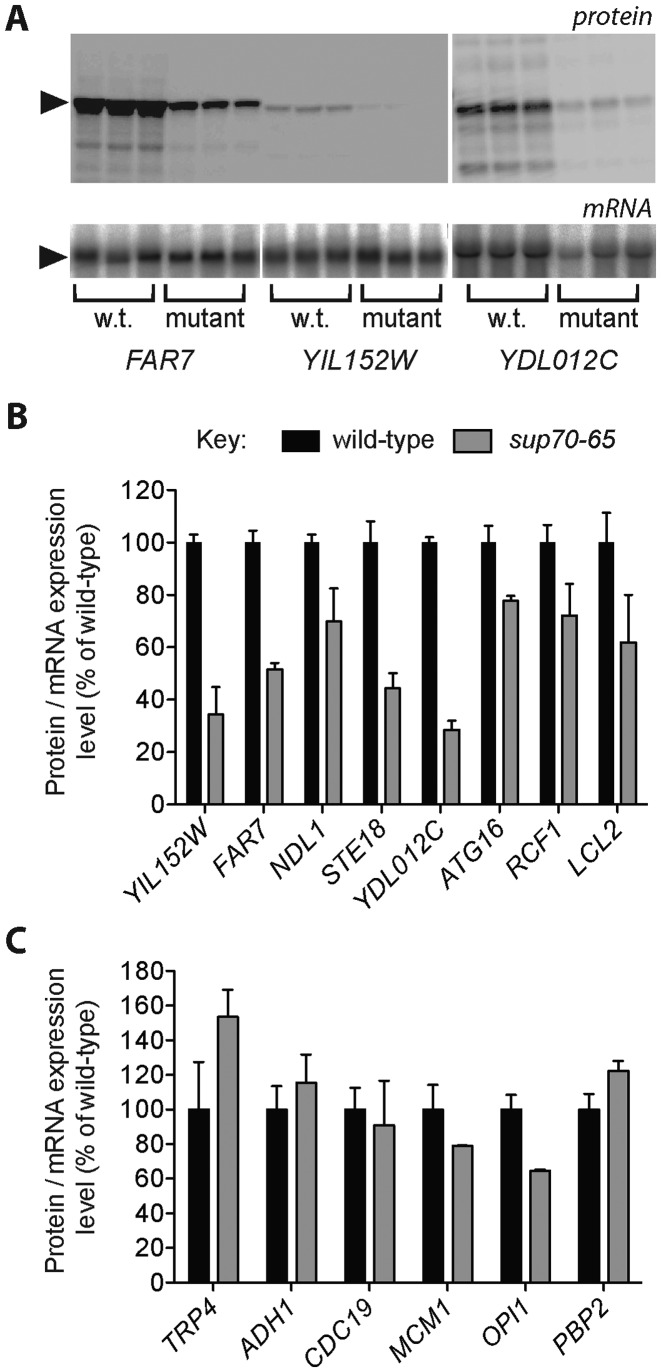
Experimental confirmation of the targets of glutamine \documentclass[12pt]{minimal}
\usepackage{amsmath}
\usepackage{wasysym}
\usepackage{amsfonts}
\usepackage{amssymb}
\usepackage{amsbsy}
\usepackage{upgreek}
\usepackage{mathrsfs}
\setlength{\oddsidemargin}{-69pt}
\begin{document}
}{}${\rm{tRNA}}_{{\rm{CUG}}}^{{\rm{Gln}}}$\end{document} regulation. (A) Quantitative Western blotting was performed for target proteins (predicted to be sensitive to cellular levels of \documentclass[12pt]{minimal}
\usepackage{amsmath}
\usepackage{wasysym}
\usepackage{amsfonts}
\usepackage{amssymb}
\usepackage{amsbsy}
\usepackage{upgreek}
\usepackage{mathrsfs}
\setlength{\oddsidemargin}{-69pt}
\begin{document}
}{}${\rm{tRNA}}_{{\rm{CUG}}}^{{\rm{Gln}}}$\end{document}) HA-tagged and expressed in either wild-type or sup70-65 mutant yeast; three examples are shown. Triplicate biological replicates were assayed for HA-tagged protein expression following gel loading normalisation. RNA expression levels for each HA-tagged construct were quantified using Northern blots, normalised for loading using an SCR1 control probe. (B) CAG-regulated mRNAs; HA-tagged protein expression levels were quantified in wild-type (black bars) and sup70-65 yeast (grey bars) for eight putative targets of \documentclass[12pt]{minimal}
\usepackage{amsmath}
\usepackage{wasysym}
\usepackage{amsfonts}
\usepackage{amssymb}
\usepackage{amsbsy}
\usepackage{upgreek}
\usepackage{mathrsfs}
\setlength{\oddsidemargin}{-69pt}
\begin{document}
}{}${\rm{tRNA}}_{{\rm{CUG}}}^{{\rm{Gln}}}$\end{document} regulation (n = 3, ± standard error of the mean). Protein expression levels were normalised using the levels of the corresponding mRNA expression levels determined by northern blot. (C) Non-CAG-regulated mRNAs; The same process was repeated for a series of control ORFs, whose expression is not predicted to be responsive to \documentclass[12pt]{minimal}
\usepackage{amsmath}
\usepackage{wasysym}
\usepackage{amsfonts}
\usepackage{amssymb}
\usepackage{amsbsy}
\usepackage{upgreek}
\usepackage{mathrsfs}
\setlength{\oddsidemargin}{-69pt}
\begin{document}
}{}${\rm{tRNA}}_{{\rm{CUG}}}^{{\rm{Gln}}}$\end{document} (n = 3, ± standard error of the mean).